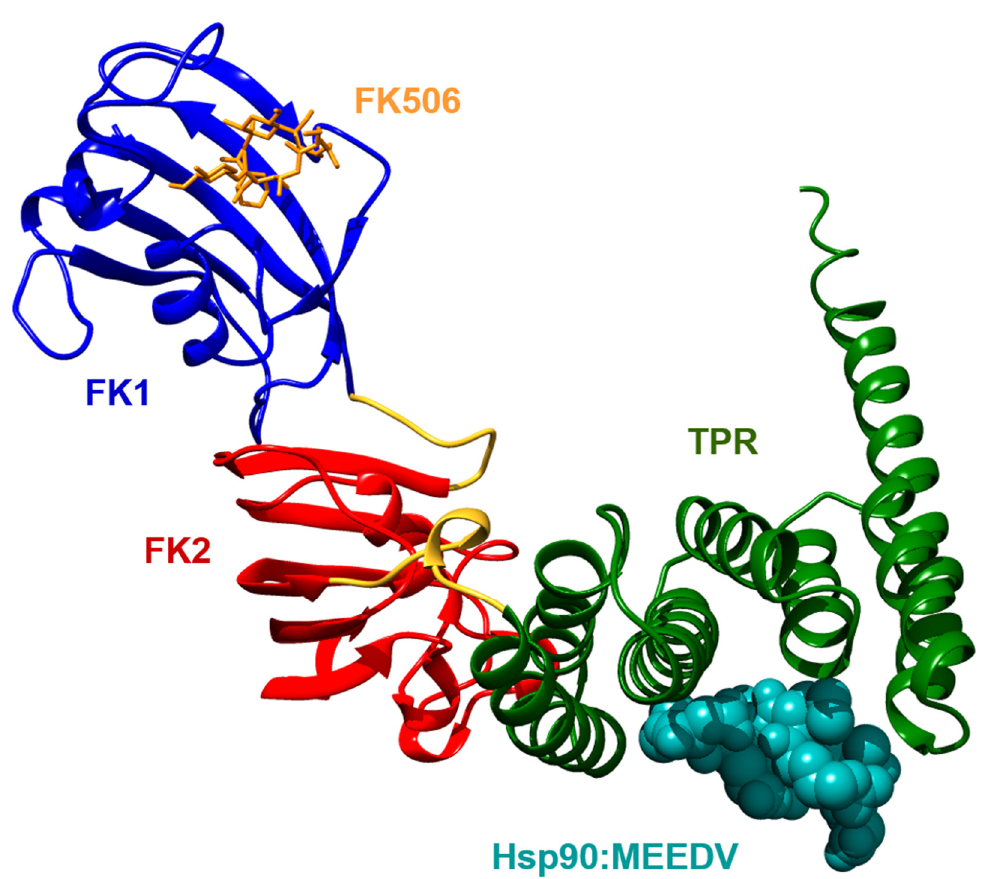
Figure 1. Full length FK506-binding protein 51 (FKBP51, PDB-ID: 1KT0) bound to the MEEDV motif derived from the heat shock protein 90 (Hsp90) C-terminus (PDB-ID: 5NJX). FK506 bound to the FK1 domain is superimposed from PDB-ID: 3O5R. TPR: tetratricopeptide repeat.